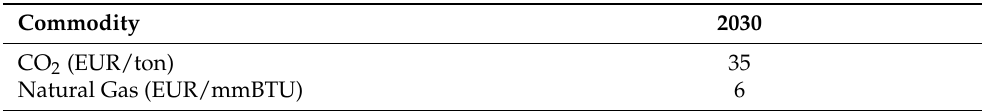
Table 4. Natural gas and CO 2 price predictions for 2030